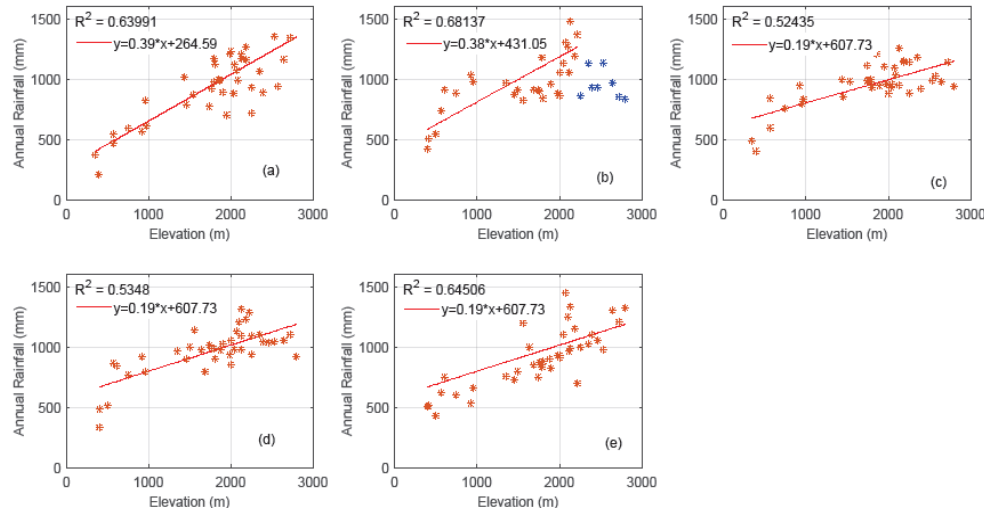
Figure 3. Long-term annual rainfall with station elevation: ( a ) gauged rainfall; ( b ) rainfall estimation from remotely sensed information using artificial neural networks—climate data record (PERSIANN-CDR); ( c ) tropical rainfall measuring mission (TRMM 3B43v7); ( d ) merged satellite-gauge rainfall estimate (IMERG); ( e ) Global Satellite Mapping of Precipitation (GSMaP)_NRT.